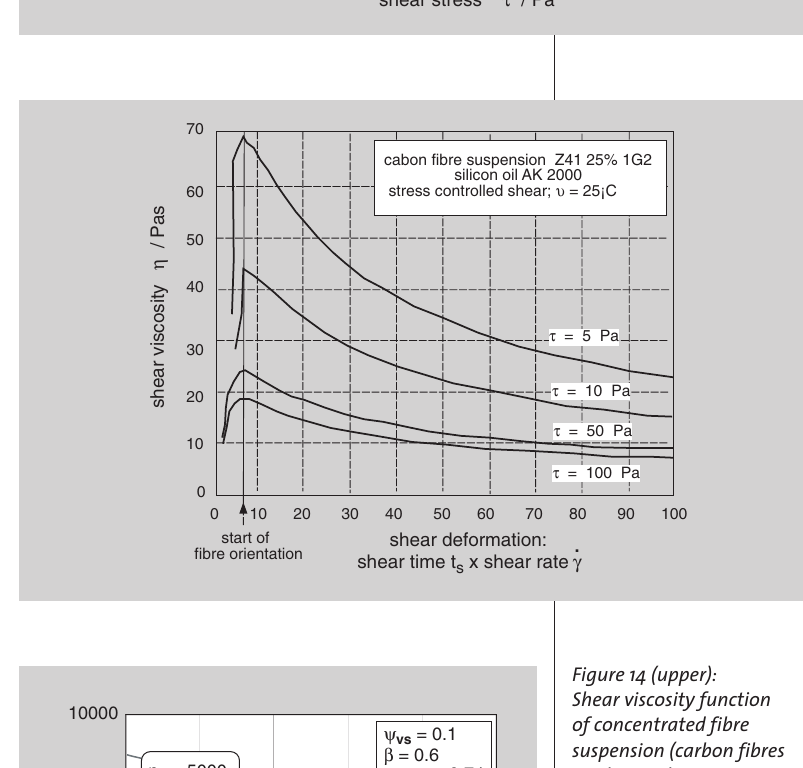
Figure 14 (upper): Shear viscosity function of concentrated fibre suspension (carbon fibres in silicon oil AK 2000; f S = 0.25); up/down functions (25°C, [16]). Figure 15 (middle): Shear viscosity versus shear deformation (shear time times shear rate) for con- centrated fibre suspension (carbon fibres in silicon oil AK 2000, f S = 0.25) at various shear stresses [16].